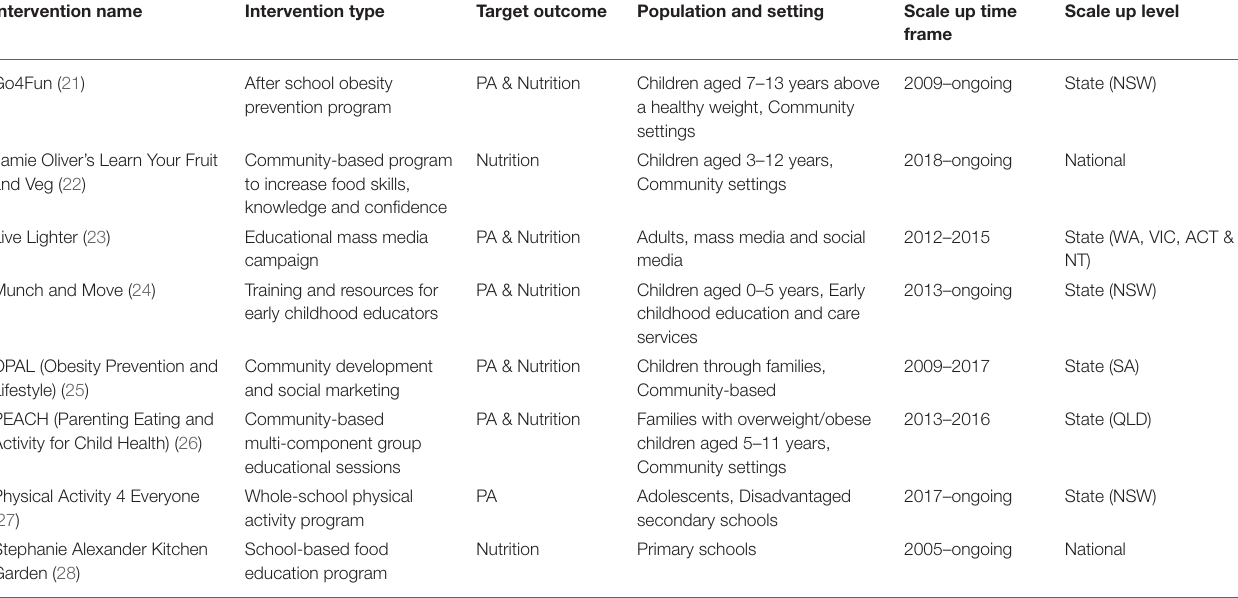
TABLE 1 | Descriptive characteristics of scaled up